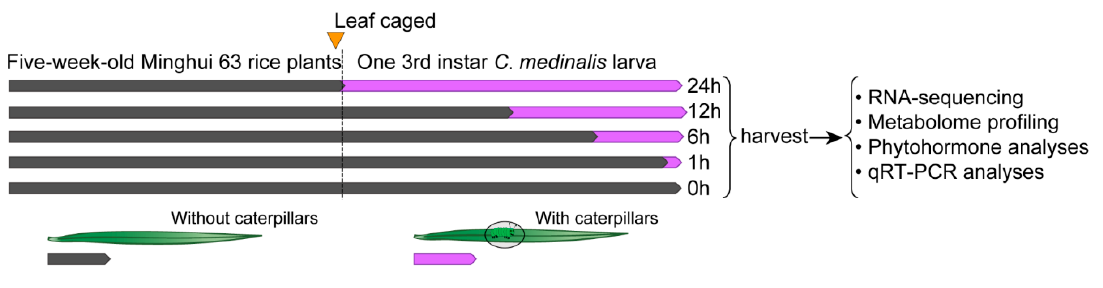
Figure 1. Design of the rice leaf folder feeding experiments. The 2nd leaf from the top of one 5-week-old Minghui 63 rice plant was enclosed in a Parafilm bag. At staggered intervals, one rice leaf folder C. medinalis caterpillar was added to each bag. Leaf tissue was harvested after 0–24 h of leaf